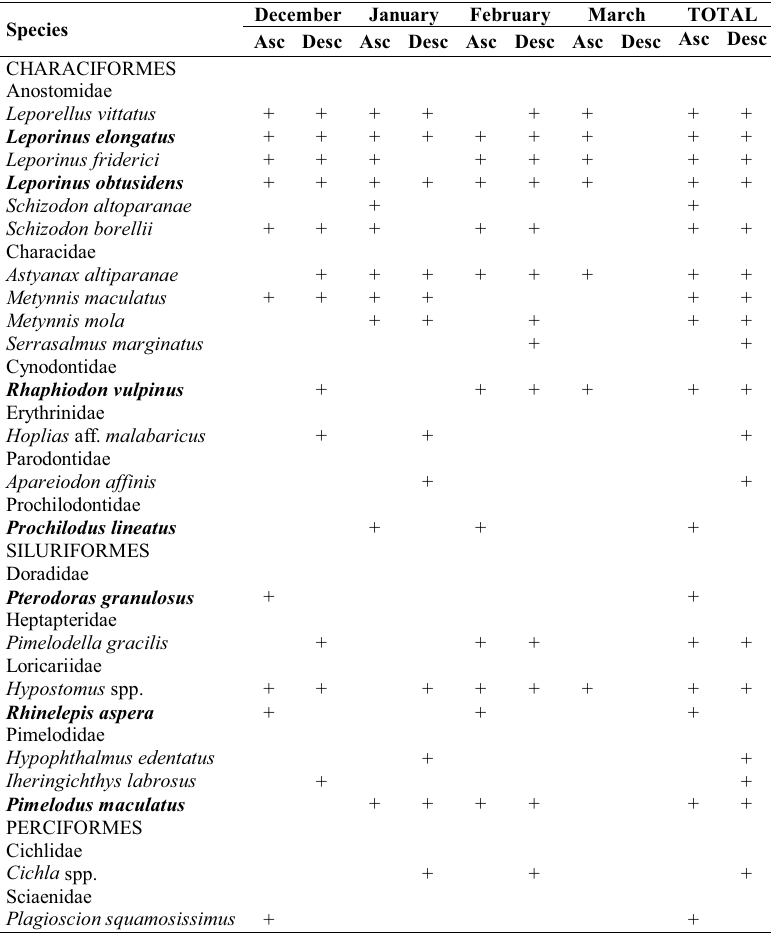
Table 2. Species occurrence in Protocol II, performed to evaluate ascending (Asc) and descending (Desc) movements in the fish ladder of Engenheiro Sergio Motta Dam, during the period of December, 2004 to March, 2005. Migratory species are in